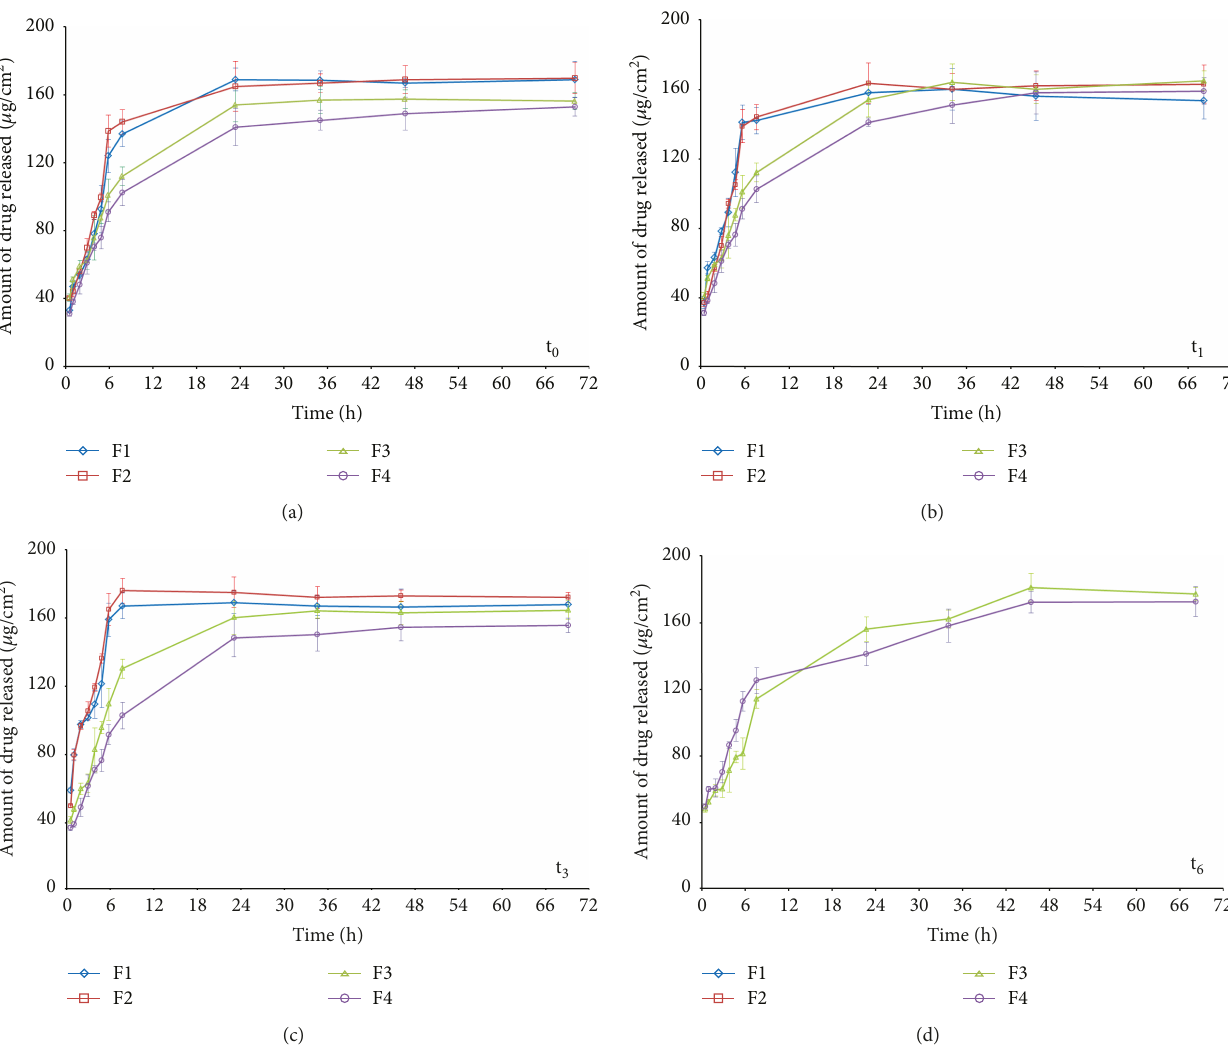
storage at ambient conditions. Figure S3: macroscopic appearance of hydrogels with unmodi fi ed CS (F1, F2) or with bGP-crosslinked CS (F3, F4) after 3-month storage at accel- erated conditions. Figure S4: macroscopic appearance of hydrogels with unmodi fi ed CS (F1, F2) or with bGP-